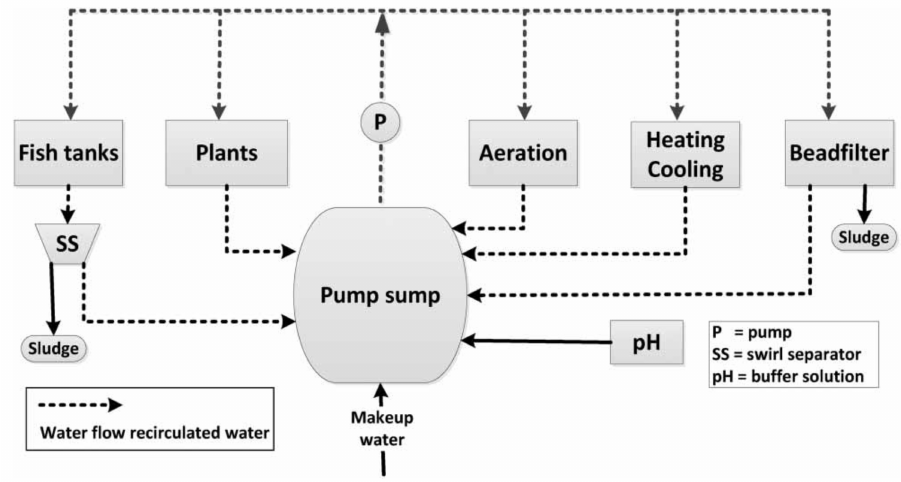
Figure 1. Flowchart of one of the two identical units of the aquaponic research facility showing water flows, water treatment, and sludge removal sites. The facility co-produced fish and vegetables with 100% recirculation of